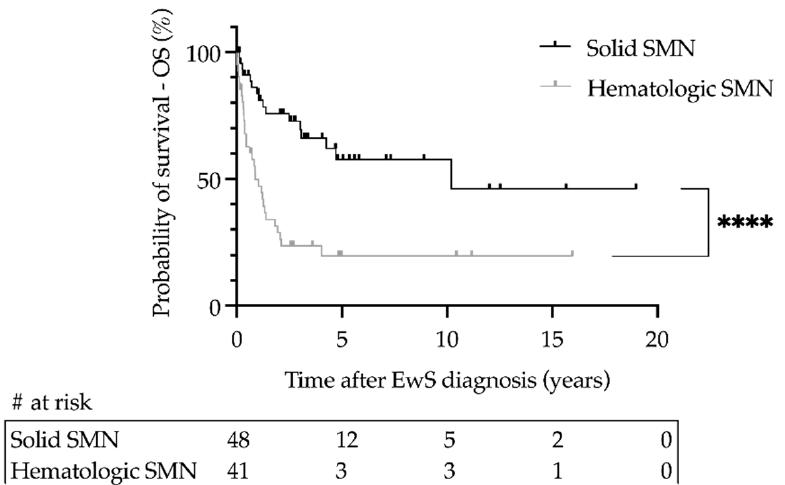
Figure 1. Survival of patients with primary Ewing sarcoma (EwS) and secondary malignant neo- plasms (SMNs) as a function of secondary hematologic or solid malignancy in the CESS 81, CESS 86, EICESS 92, Euro-E.W.I.N.G. 99, and Ewing 2008 trials. Overall survival (OS) was calculated using the Kaplan–Meier method. **** p < 0.001. # at risk—number of patients at